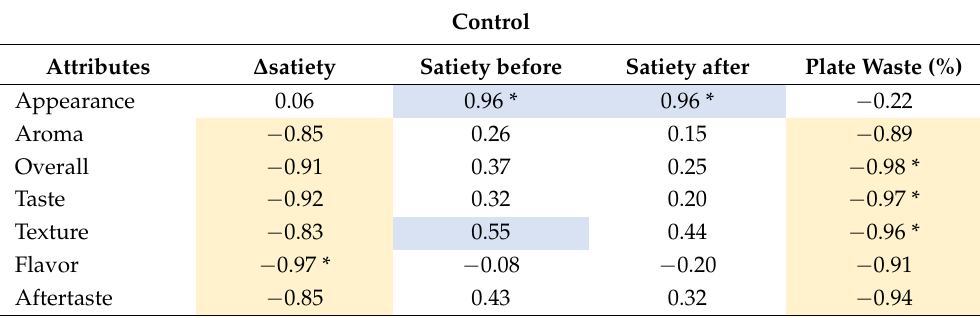
Table 4. Correlation coefficients between attribute liking scores, ΔSatiety, satiety before and after, and plate waste. Coefficients were either colored blue if r > 0.50 or yellow if r < − 0.50. Correlation coefficients denoted were found to be significant ( p < 0.05).